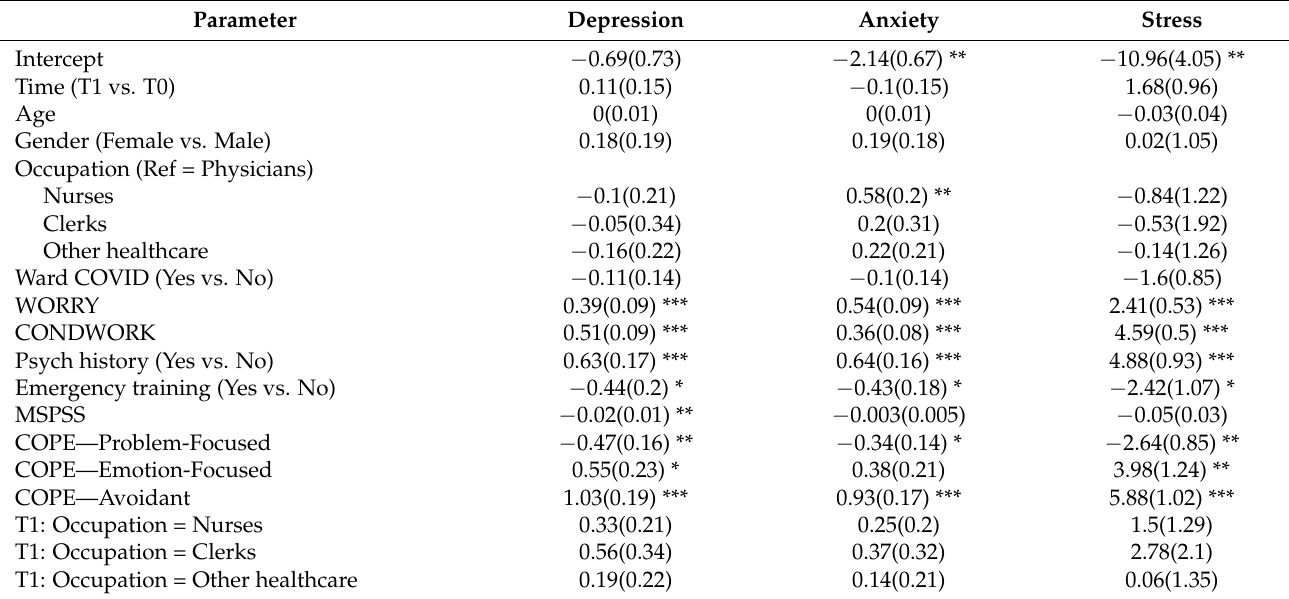
Table 3. Estimates (standard-errors) of the models for the DASS-21 subscales. Depression and anxiety scales were square root